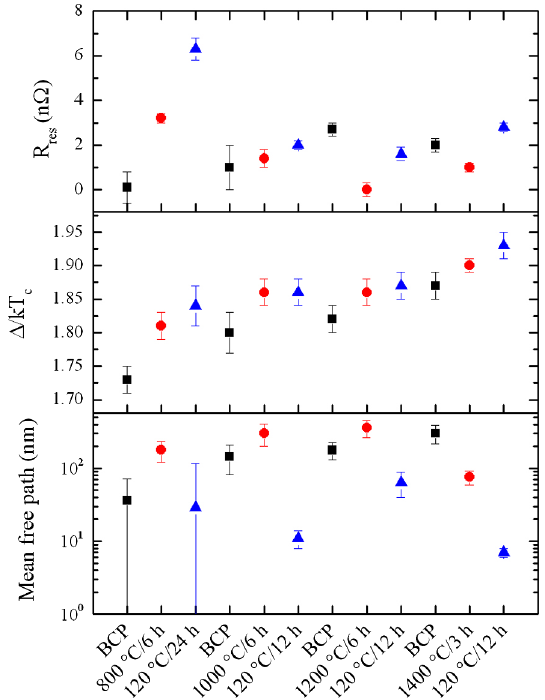
FIG. 10. Mean-free path, (cid:2) =kT c and R the various treatments: BCP (squares), HT (circles), and LTB (triangles).